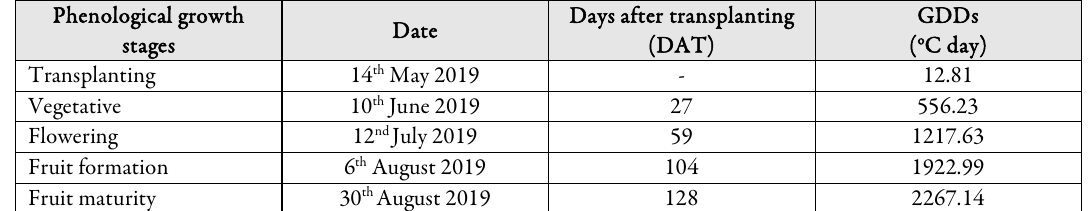
Table 1. Accumulated Growing Degree Days (GDDs) from transplanting to fruit maturity and dates of basic phenological stages obtained during the growing